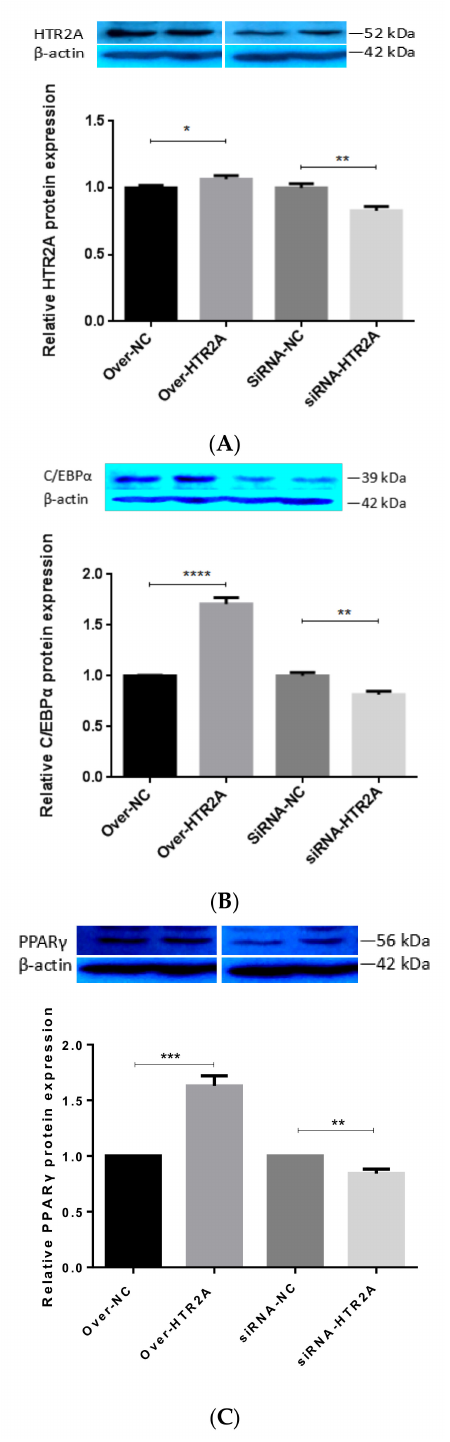
Figure 7. Regulation of adipogenesis markers by HTR2A. ( A ) The detection of HTR2A expression; ( B ) the detection of C/EBP α expression; ( C ) the detection of PPAR γ expression. The lanes in all of the Western blots were overexpression negative control, overexpression, knockdown negative control, and knockdown group from left to right. Values are means ± SD. vs. control group, ** p < 0.01; *** p < 0.001 and **** p <